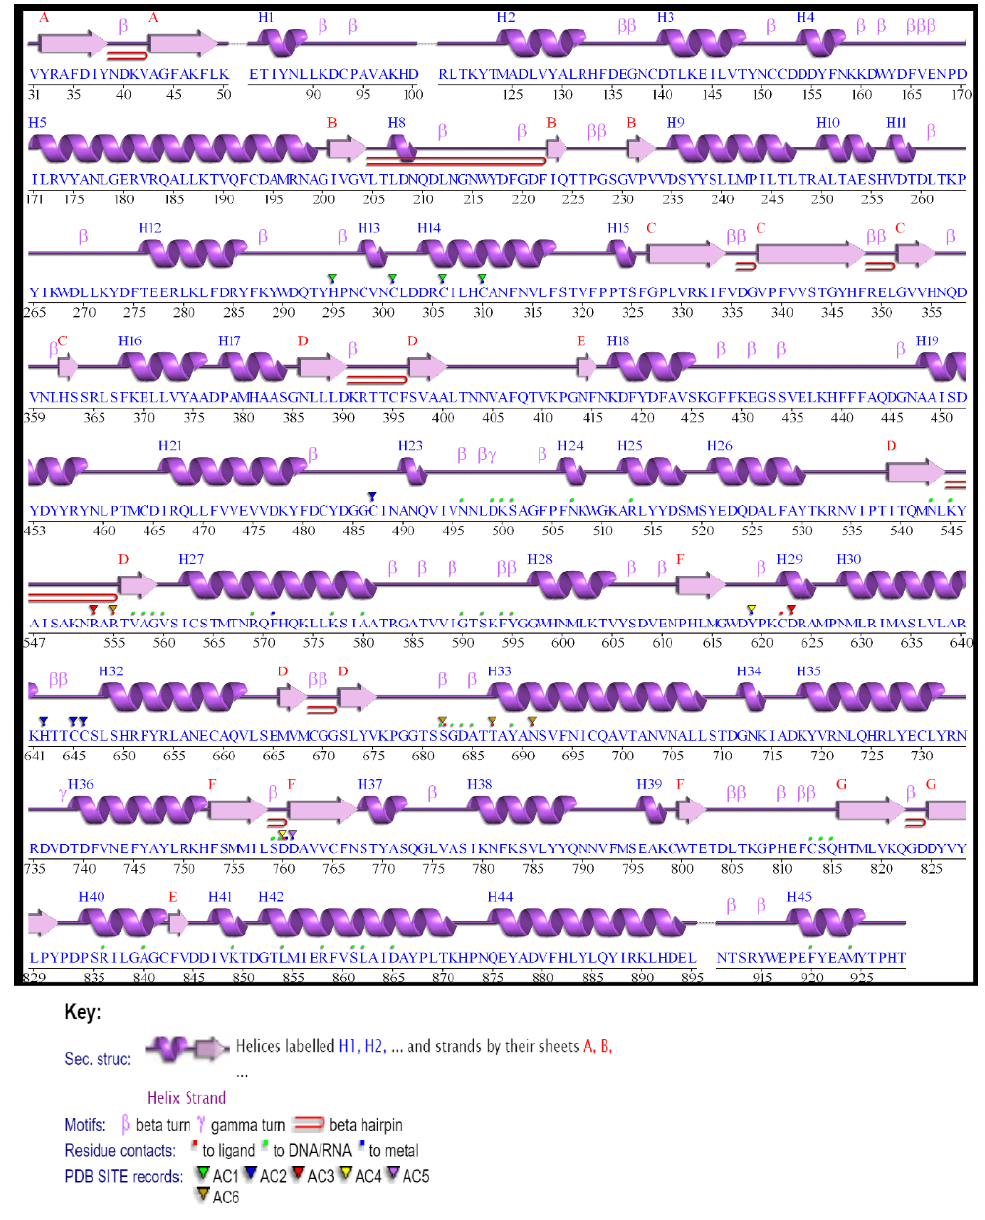
Figure 4. Sequence structural pattern overlapping. The figure was generated by JPred4 website (http://www.compbio.dundee.ac.uk/jpred4; accessed on 13 January 2021).